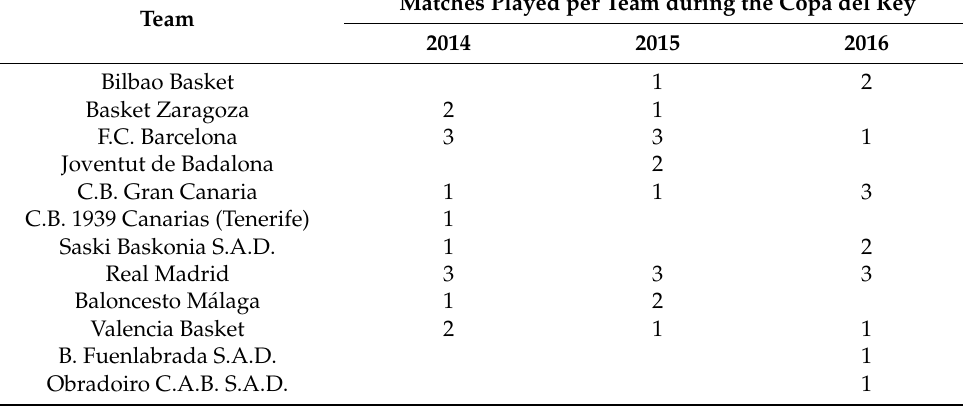
Table 1. Participating teams in the 2014, 2015 and